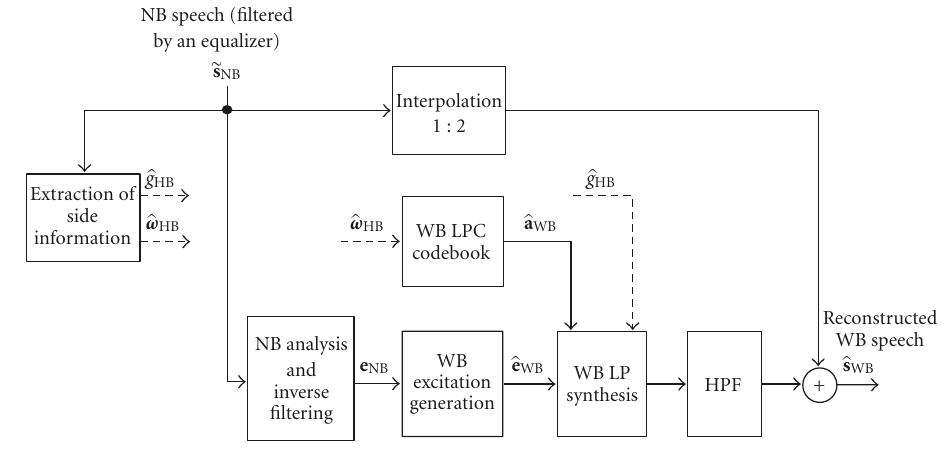
Figure 4: SBE decoder